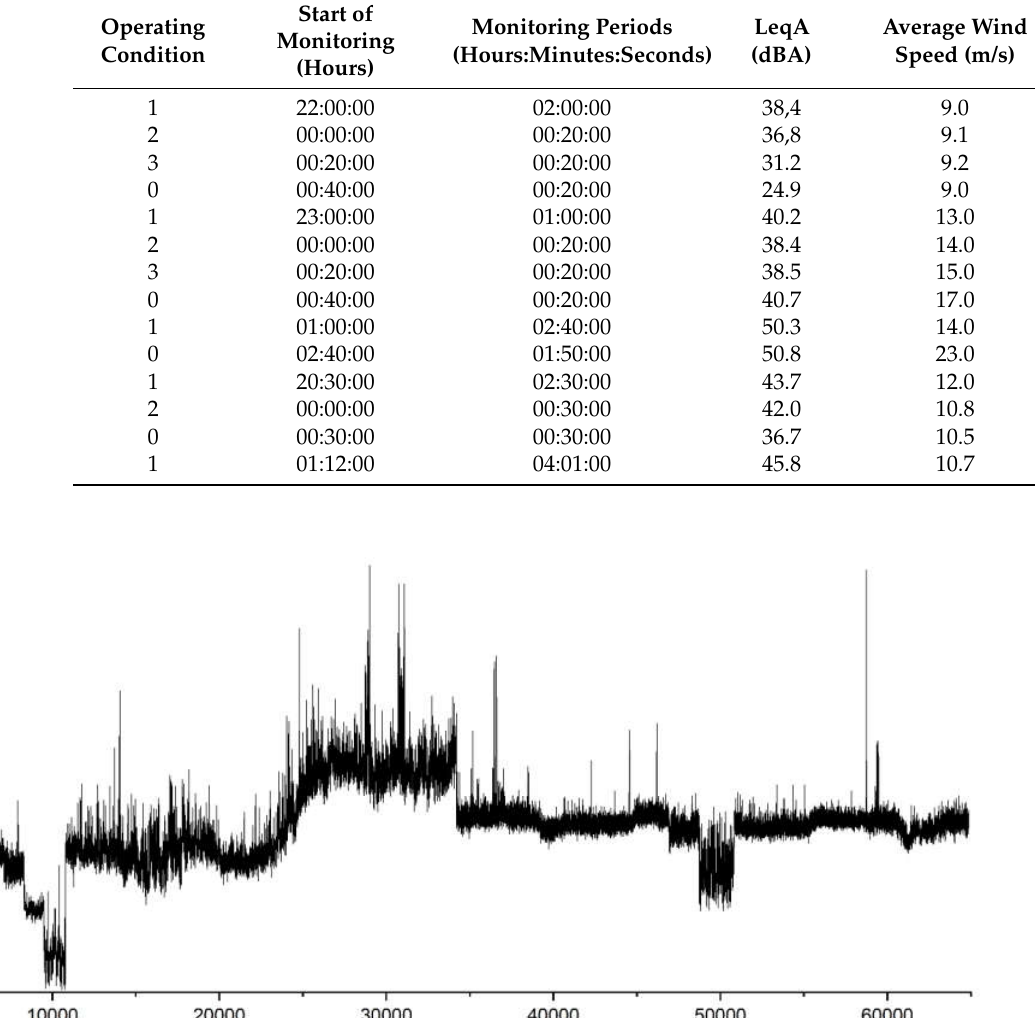
Table 1. Summary of the acoustic measurements carried out in time intervals representative of different operating conditions. The measurements refer to several days of monitoring (Figure 3).